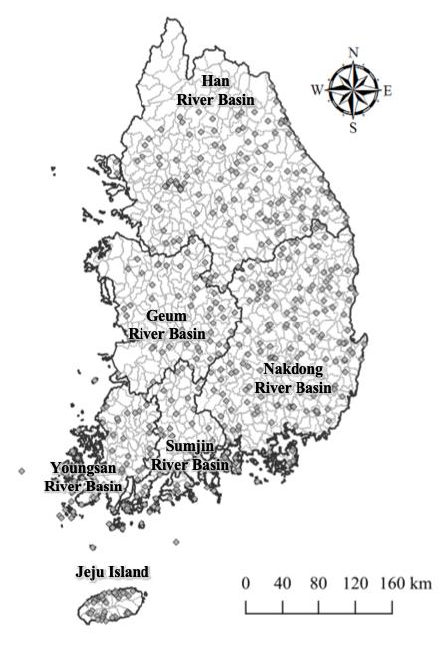
Figure 2. Riverbed water intake facilities in South Korea.